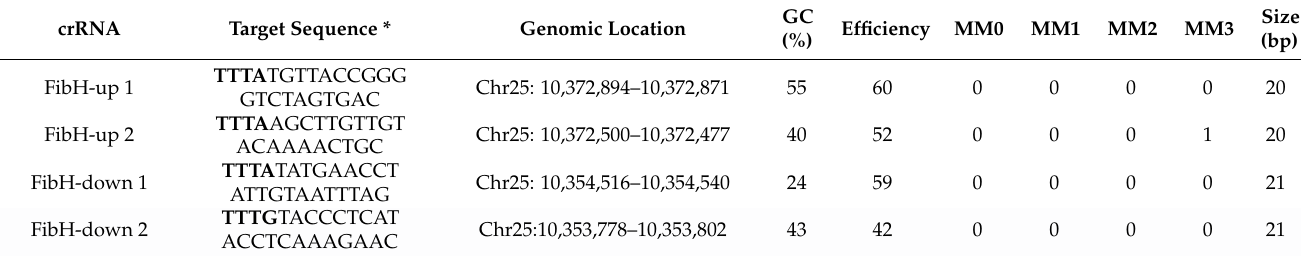
Table 1. crRNA activity predicted by CHOPCHOP. Efficiency is the abbreviation of the efficiency score, which is obtained by position-specific scoring matrix or support vector machine based on the current literature. MM0, MM1, MM2, and MM3 represent the number of potential off-targets with 0, 1, 2, and 3 mismatches, respectively. crRNA